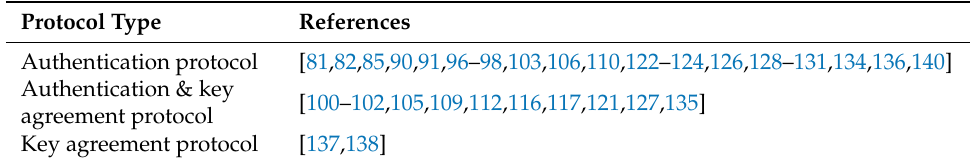
Table 2. The summary of protocol types.